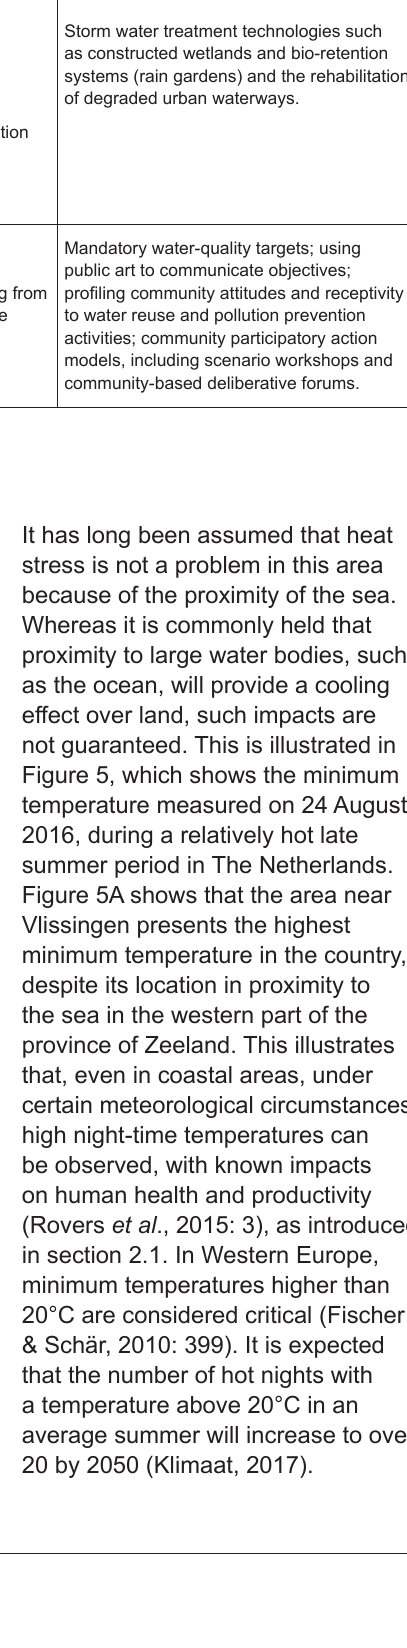
Integrating urban development and water management based on three pillars for WSUD Pillar of WSUD Explanation Example Cities as water-supply